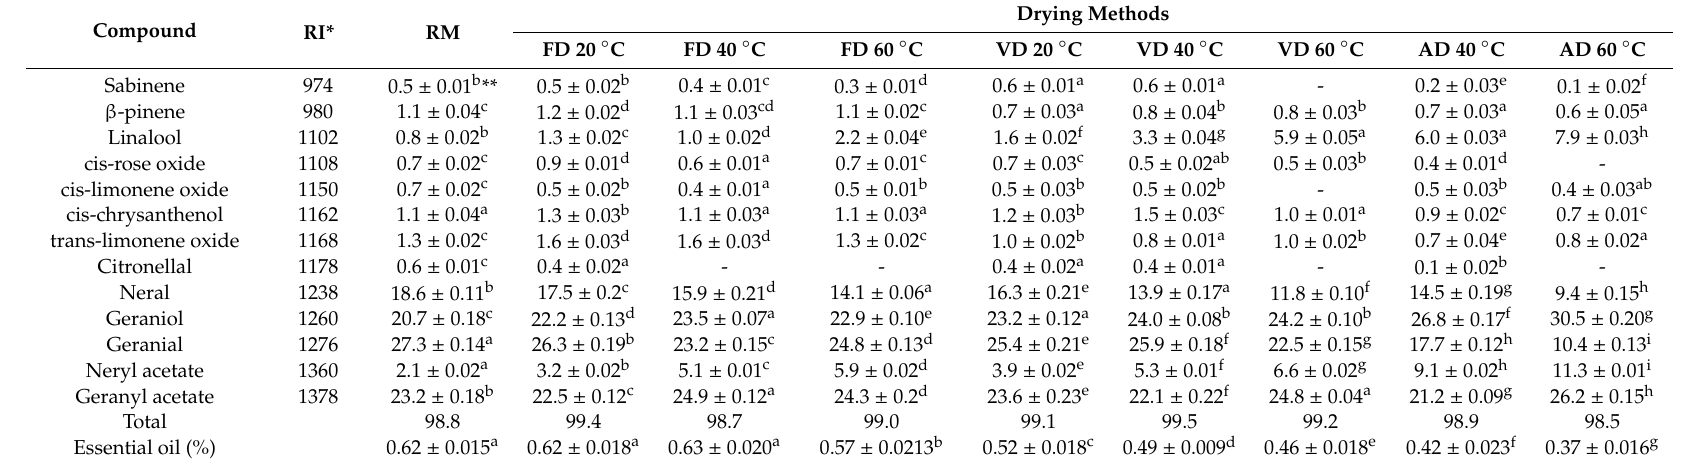
Table 10. Oil composition of Moldavian dragonhead leaves influenced by di ff erent drying